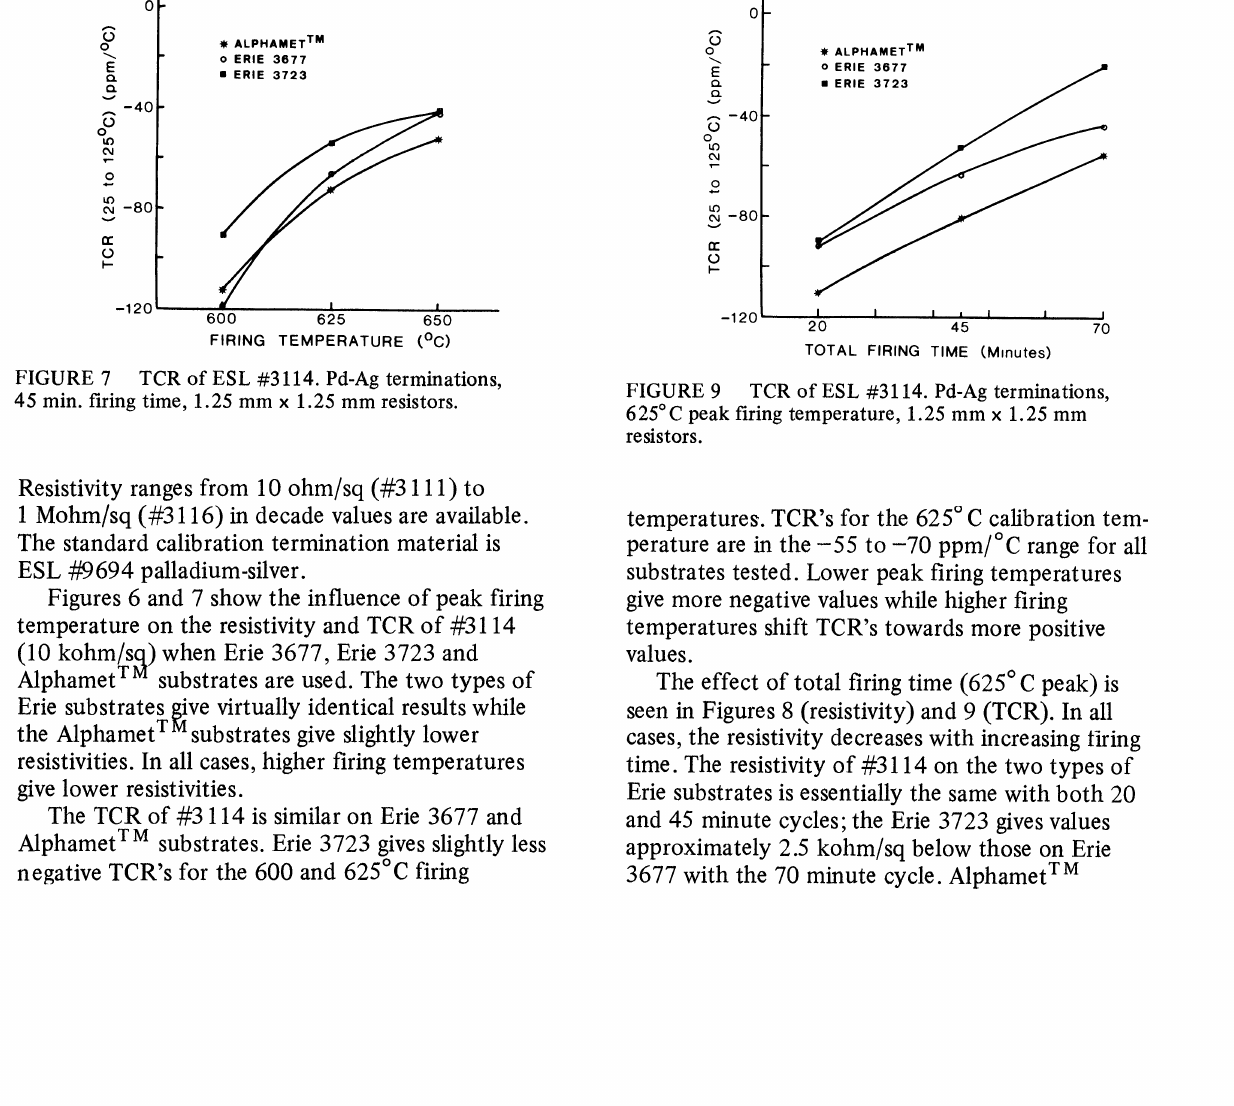
Resistivity of ESL #3114. Pd-Ag terminations, 45 min. firing time, 1.25 mm x 1.25 mm resistors.